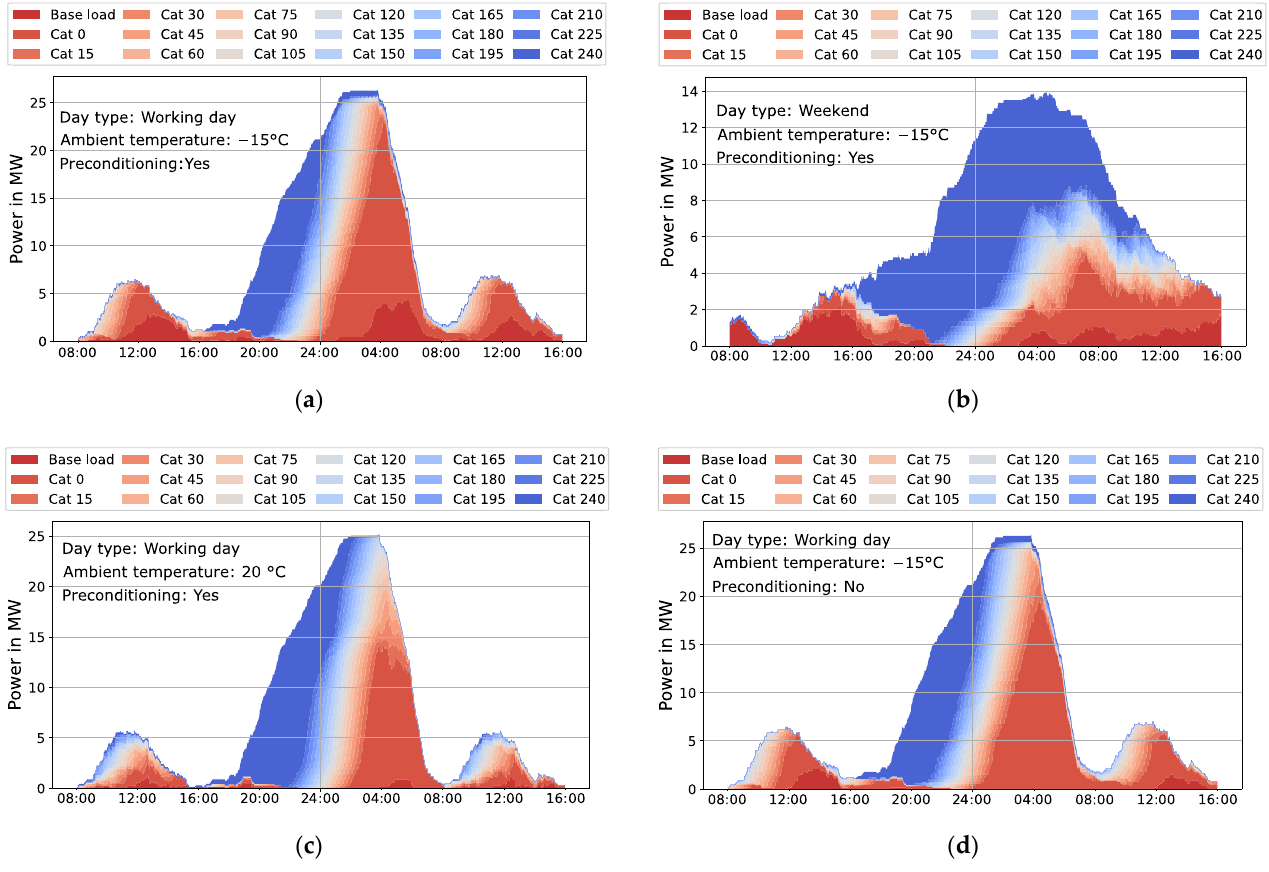
Figure 11. Comparison of the available power and time flexibility for ( a ) original scenario, as well as scenarios with changed ( b ) timeline (working day or weekend), ( c ) ambient temperature, and ( d ) electrical preconditioning.